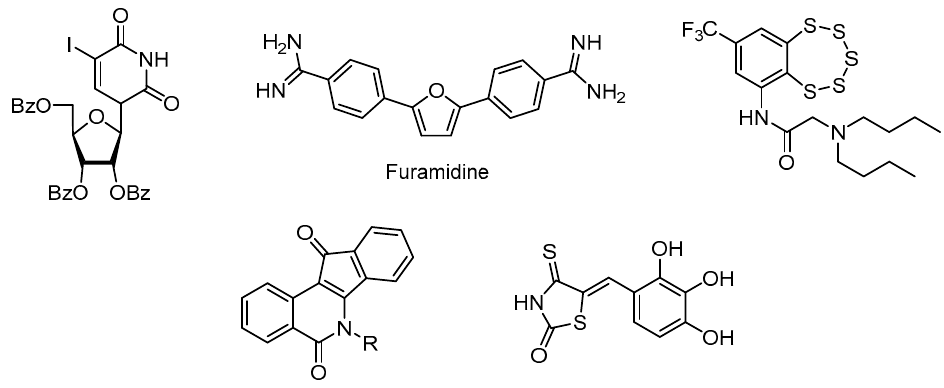
Figure 1. Structures of known TDP1 inhibitors.